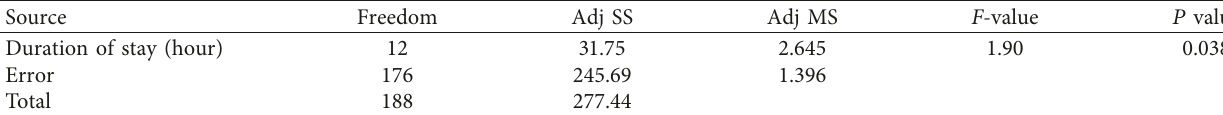
Table 2: Variance analysis table for travel mode and travel time.